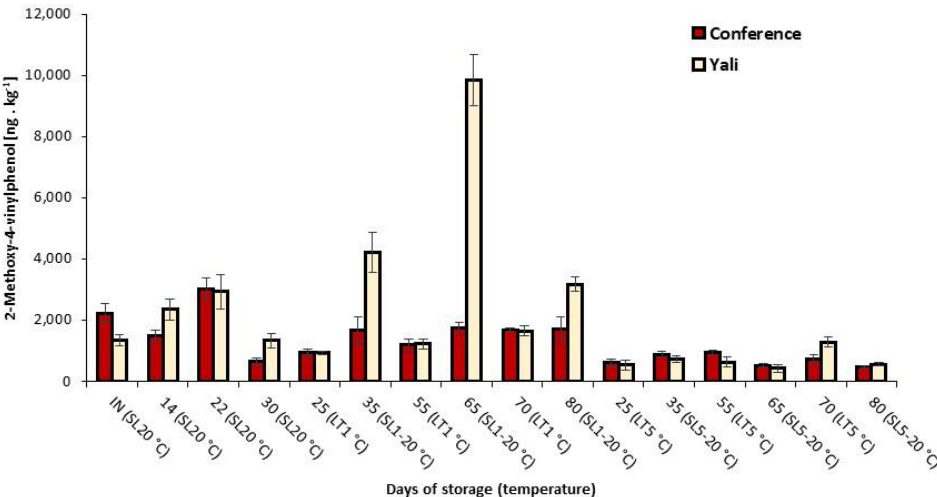
Figure 5. Concentration changes of 2-methoxy-4- vinylphenol in ‘Conference’ and ‘Yali’ pear culti- vars depending on time and storage regimes. (SL20 °C — shelf-life at 20 °C; LT — low storage at 1 or 5 °C; SL1-20 °C, SL5-20 °C — shelf-life at 20 °C after storage at 1 or 5 °C).